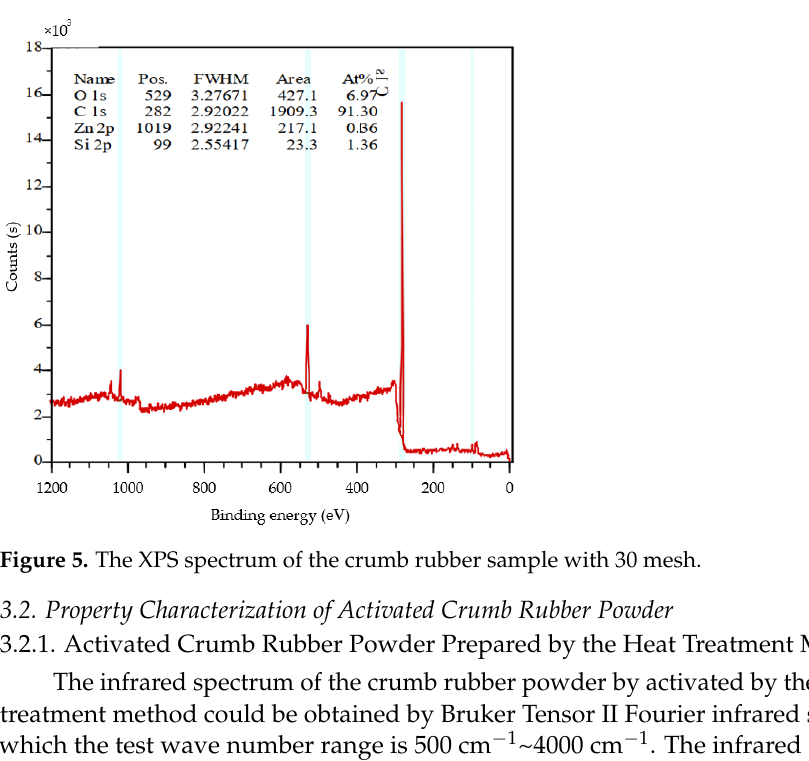
Table 3. The element content results of the crumb rubber sample with 30 mesh.